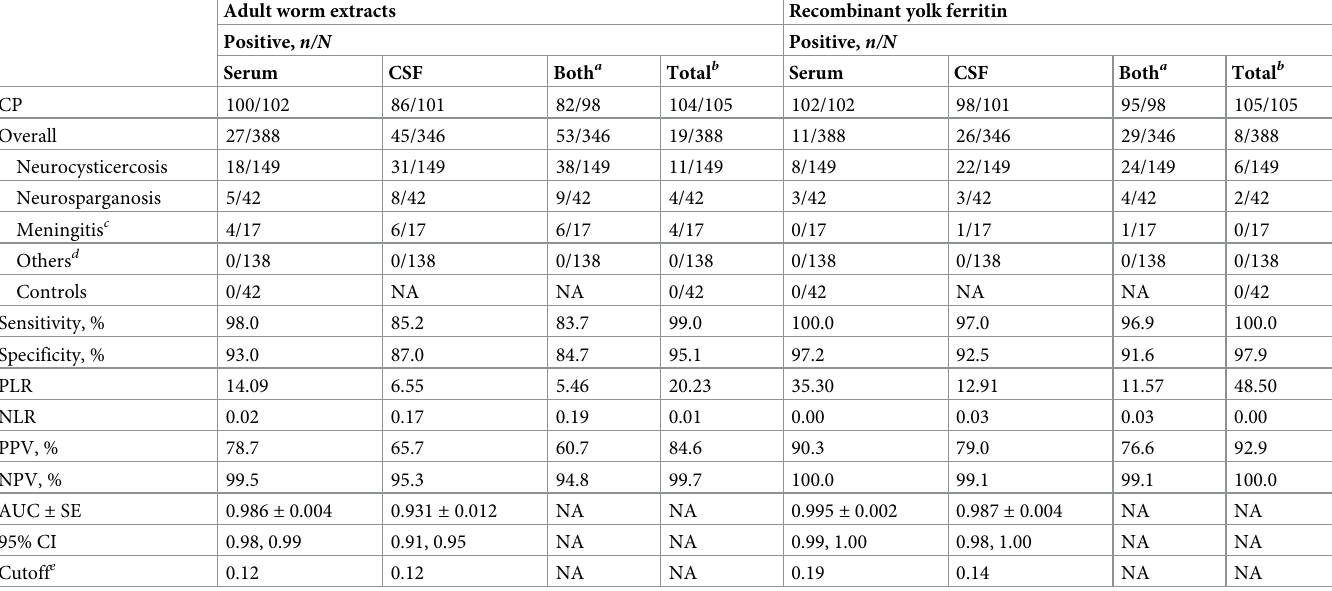
Table 3. Evaluation of the biomarker potential of different antigenic preparations for the serodiagnosis of cerebral paragonimiasis.